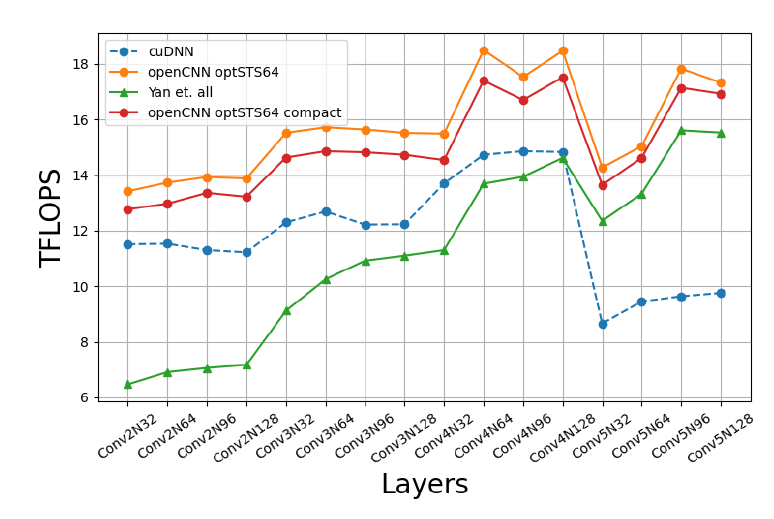
Figure 18. Winograd openCNN performance on Ampere RTX